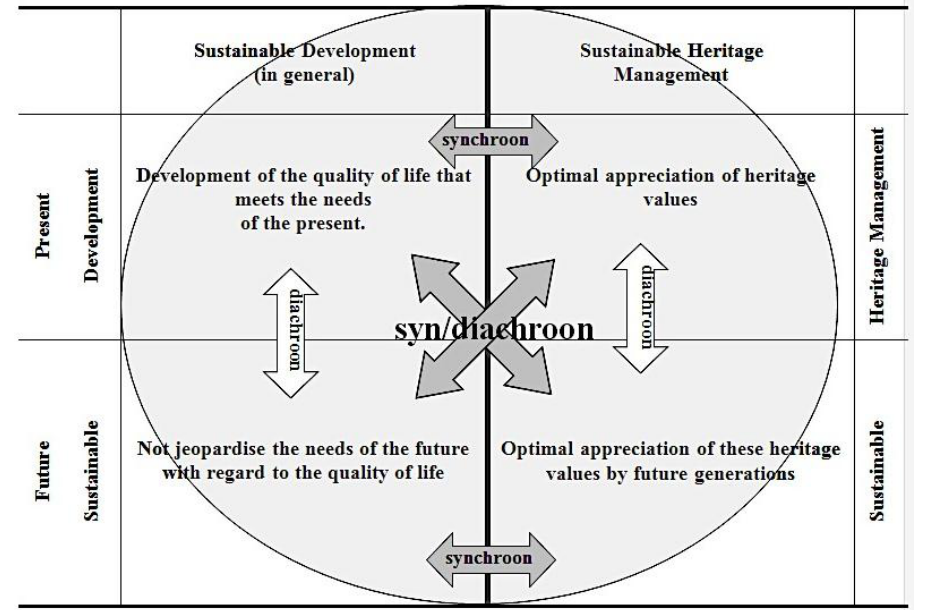
Figure 1. Integrated approach of SD of heritage sites.